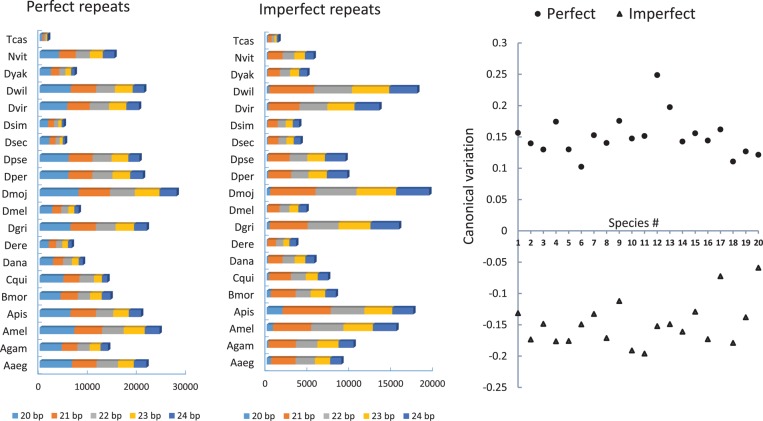
Stacked bar graphs showing variation in the number of perfect and imperfect repeats among the 20 insect species. The stacks in the graph represent different lengths of microsatellites as shown below the graphs. The scatter graph on the right shows the canonical variation of frequency of microsatellites of different length for each species. The species are indicated as 1 through 20 on x-axis and the canonical variation is shown in y-axis.